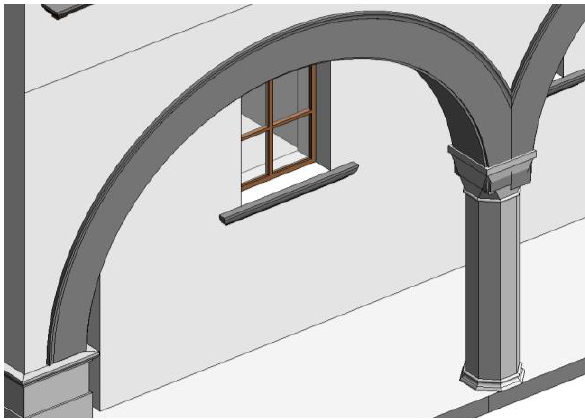
Figure 4. Modeling problems at column capital (at